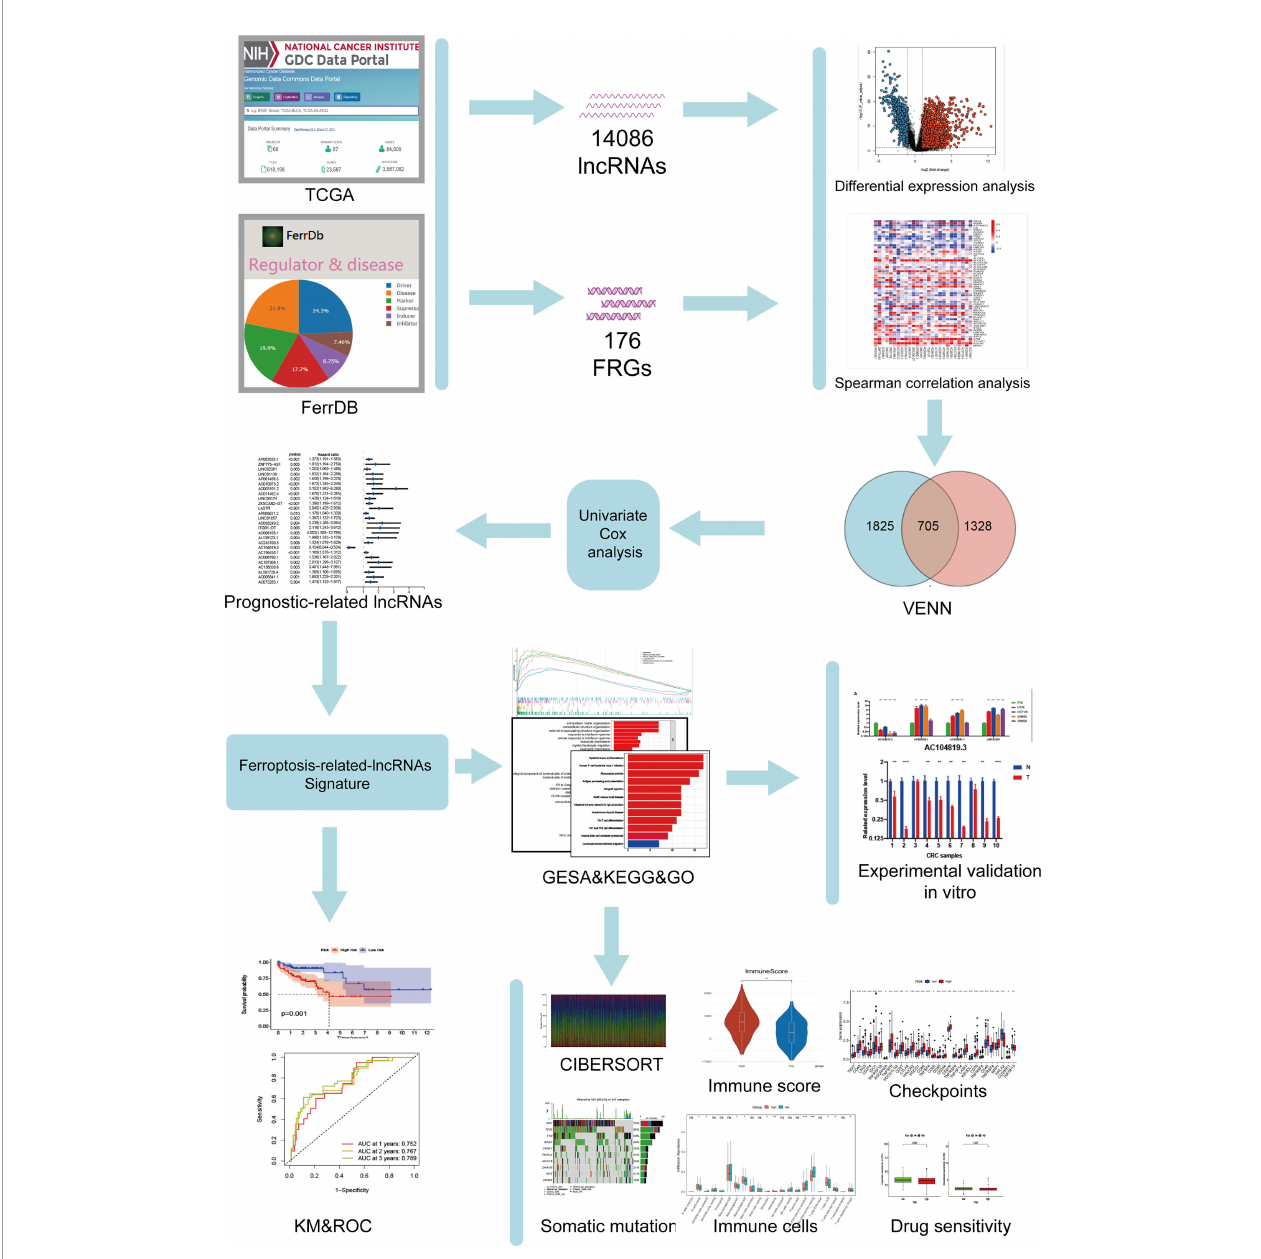
FIGURE 1 | Study fl owchart. A total of 14086 lncRNAs and 176 ferroptosis-related genes (FRGs) were obtained from TCGA and FerrDb databases, respectively. Then, 705 ferroptosis-related lncRNAs (FRLs) was identi fi ed according to Spearman correlation analysis. Next, univariate COX analysis was applied to screen for the prognostic FRLs. Based on this analysis, a 4-FRL signature was constructed. Subsequently, GSEA, KEGG, GO analyses, immune-related analyses, somatic mutation, and drug sensitivity assays were applied to identify the potential function of this signature. Finally, in vitro validations were conducted to explore the expression and function of these